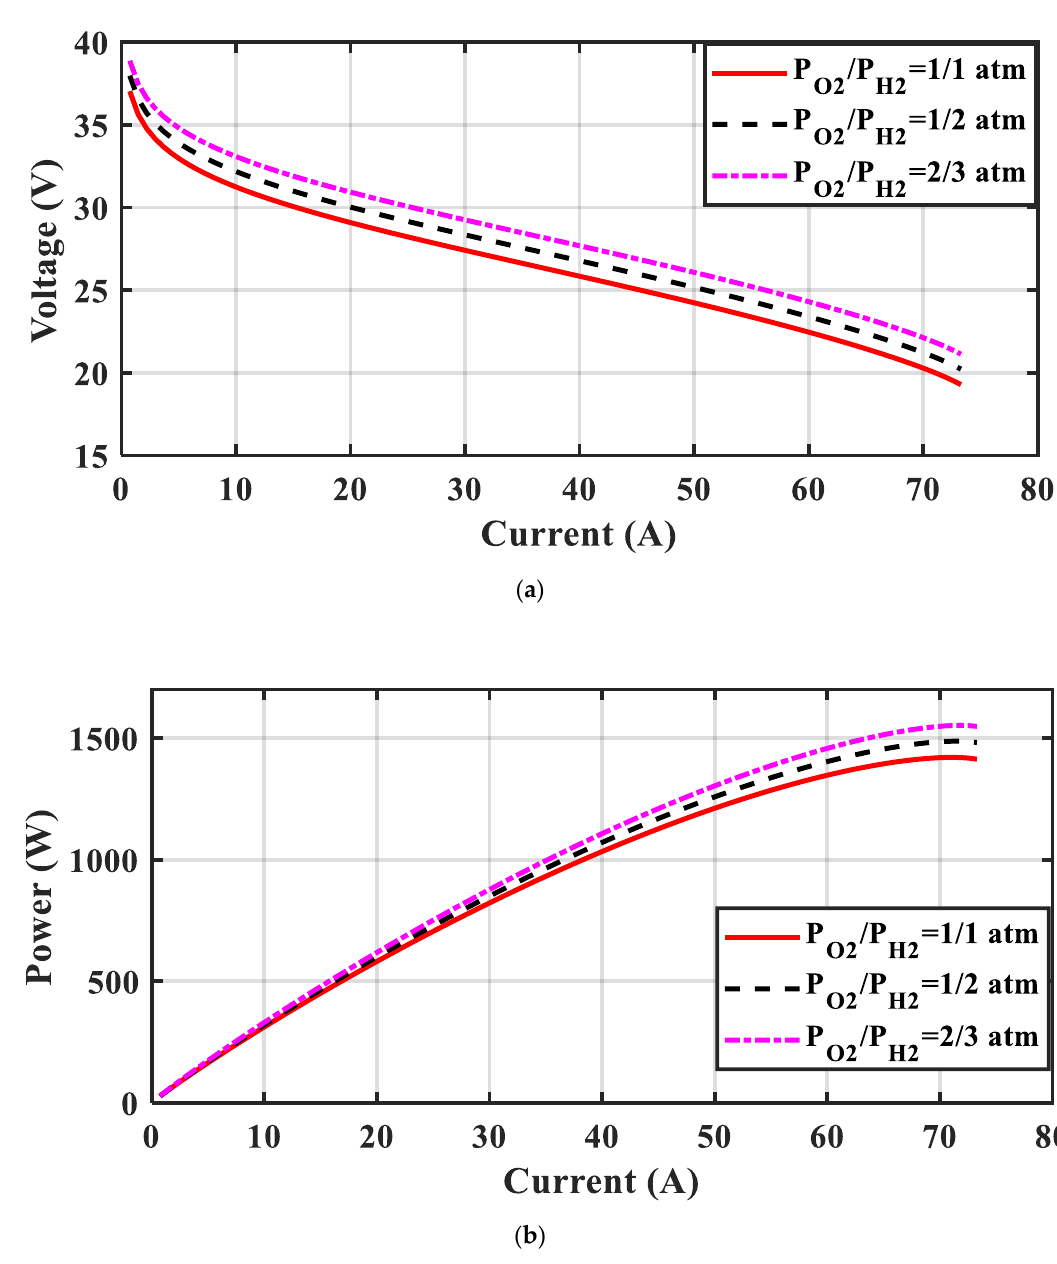
Figure 5. Polarization curves of Ballard fuel cell using the HGS algorithm under various pressure conditions with constant temperature. ( a ) I – V curves. ( b ) I – P curves.